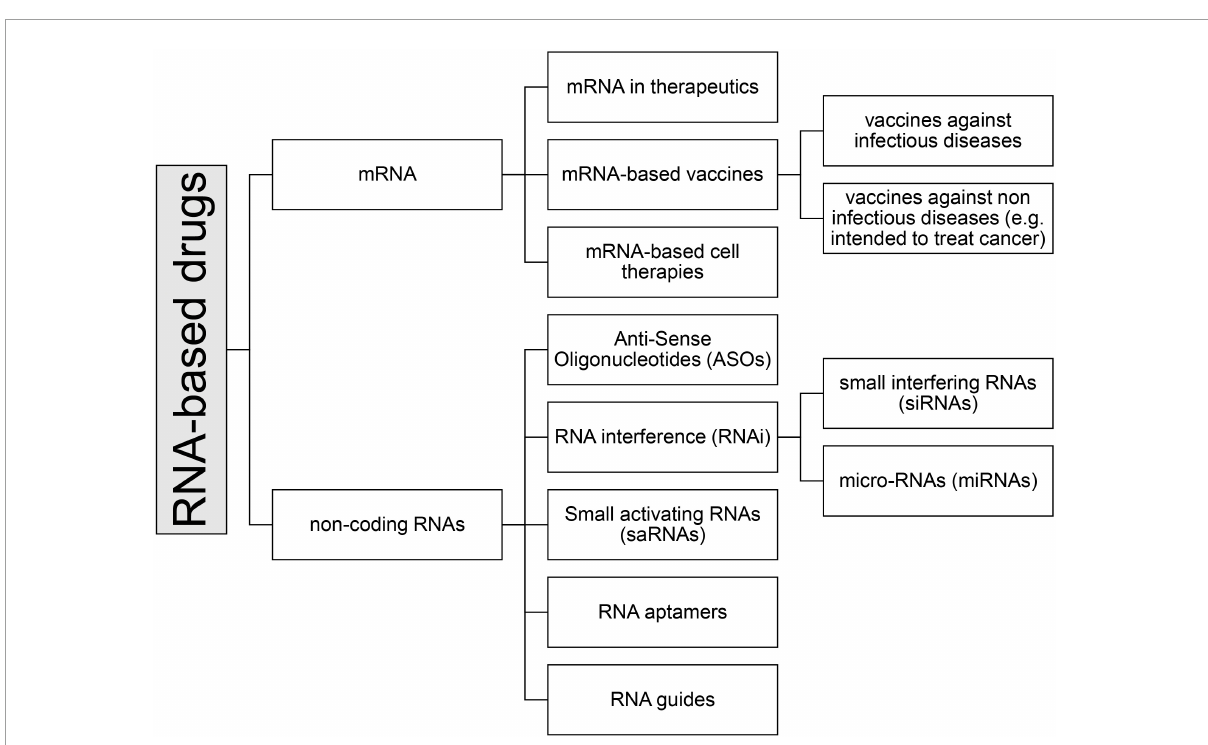
FIGURE2 Classification of RNA-based